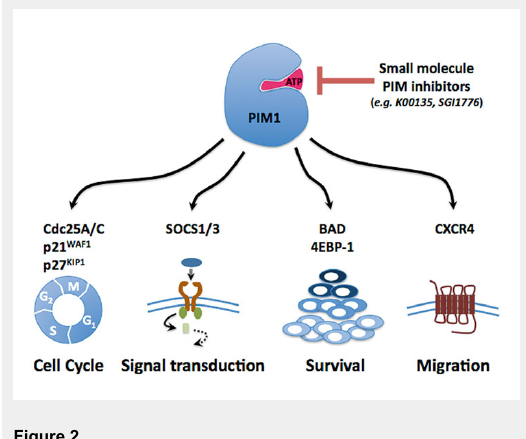
PIM1 as potential therapeutic target in acute leukaemia. Different signalling pathways involving substrates of PIM1 kinase contribute to its oncogenic activity. By targeting PIM kinase with small molecule inhibitors it is not only possible to block cell cycle progression and survival of the leukaemic cells, but this may also help to mobilise the leukaemic stem cells by interfering with the CXCL12/CXCR4 axis